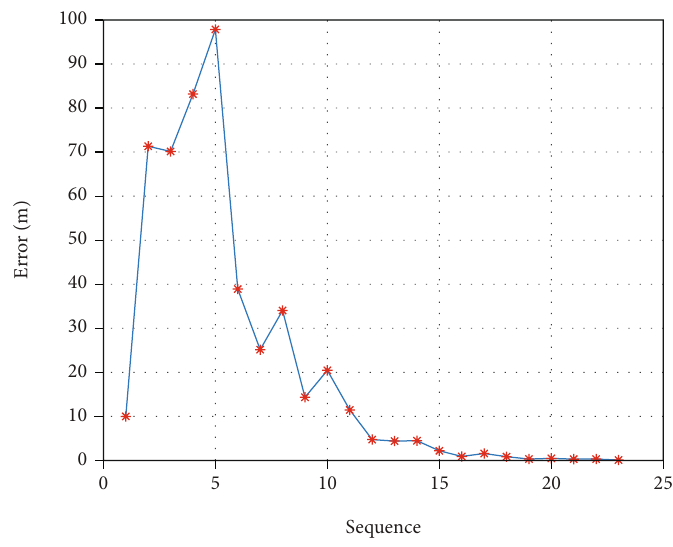
Figure 9: Simplex convergent error variation diagram with a range of 6000 km. Table 4: Optimal navigation star at di ff erent